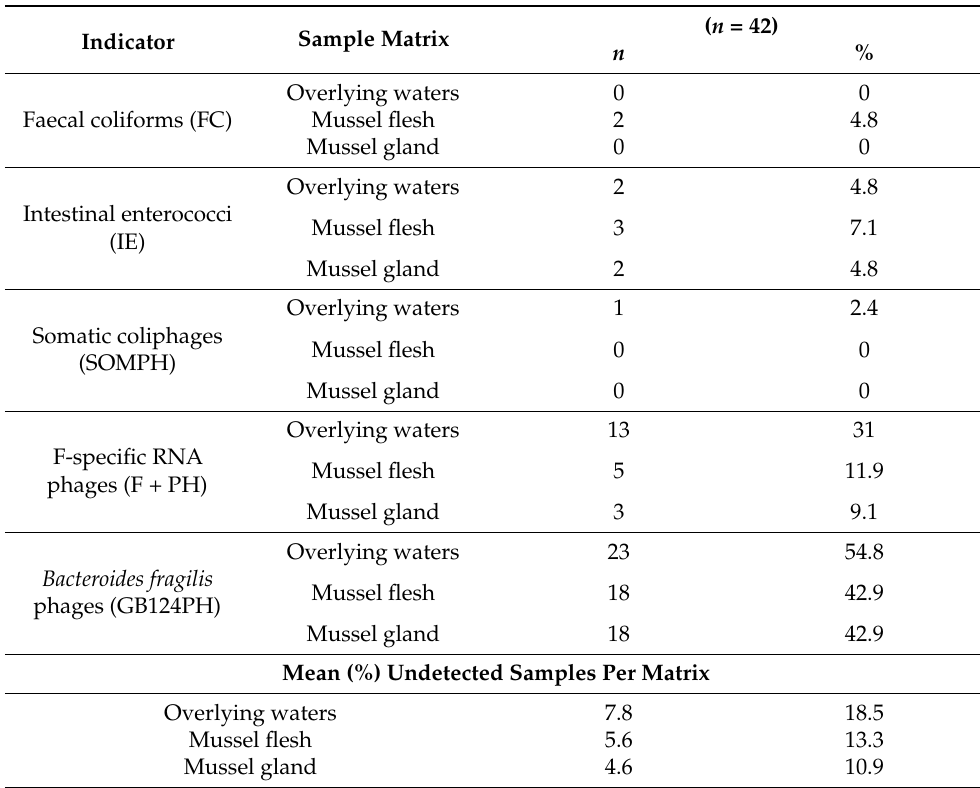
Table 1. Number ( n ) and percentage (%) of samples from each sample matrix in which faecal indicators were undetected during field-based research (including preliminary